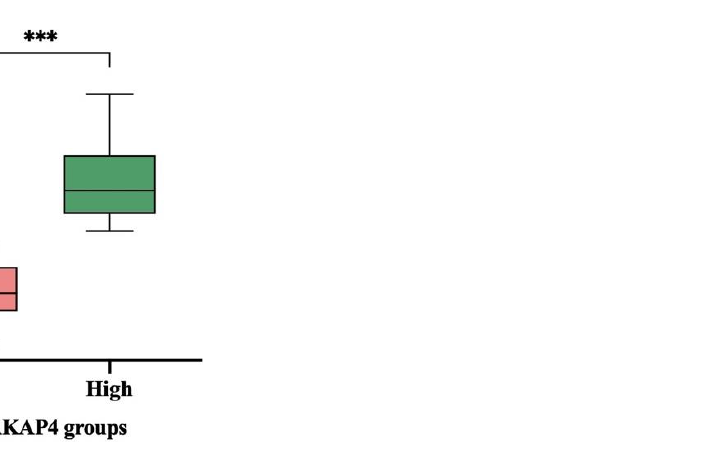
Figure 1. Box – whisker plot showing the proAKAP4 concentration (ng/10M spz) of frozen – thawed horse ejaculates as having low (n = 23; red) or high (n = 25; green) proAKAP4 concentrations. The line indicates the median, the boxes enclose the 25th and 75th percentiles, and the whiskers extend to the 5% and 95% percentiles (*** p ≤ 0.001).